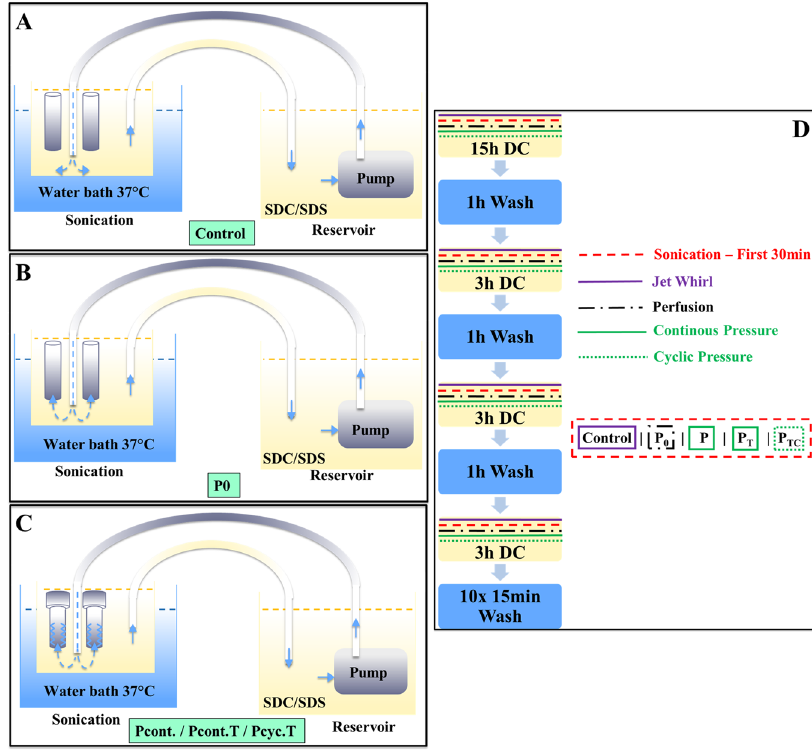
Fig. 1 Schematic representation of the bioreactor and the used decel- lularization schemes for different incubations. In ( A ) the bioreactor setup for the Control (Ctrl) group is depicted, where the aortas are not fi xed at the bottom but fl oat in the decellularization solution. B Shows the setup for the P0 group (no pressure applied), where the aortic segments are fi xed at the bottom of the bioreactor, enabling a bottom up perfusion of segments with decellularization solution. C Shows the setup for the Pcont. (application of continuous pressure),